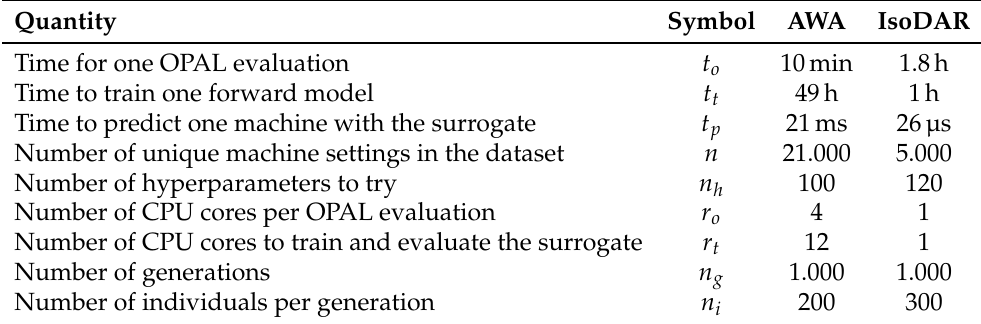
Table A8. Parameters related to the speedup calculation. For the AWA, the prediction time refers to predicting the beam properties with a spacing of 5 cm, i.e., at 520 positions. For the IsoDAR accelerator, we modelled only 1 position. The times are measured by measuring the prediction time for predicting N m machines and then dividing by N m . For the AWA case, N m = 64; for IsoDAR N m = 2 20